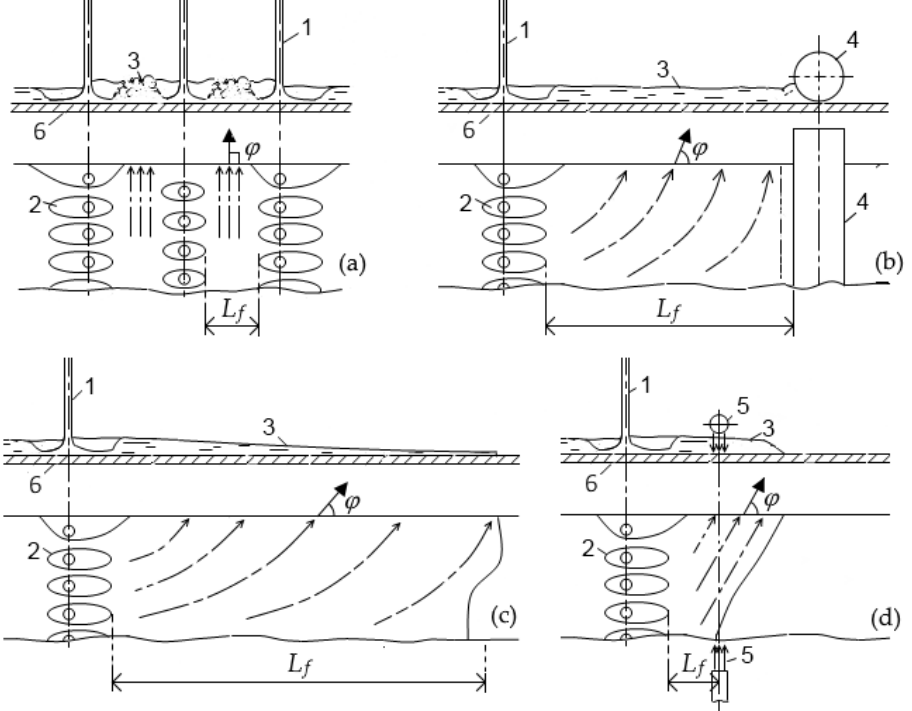
Figure 6. Different types of subcritical flow zone (“water layer”): ( a ) clamped, ( b ) bounded, ( c ) open and ( d ) shifted. Designations: 1—jet, 2—supercritical flow area, 3—water layer, 4—roll, 5—separator. L f is the length of the water layer; φ is the runoff angle.